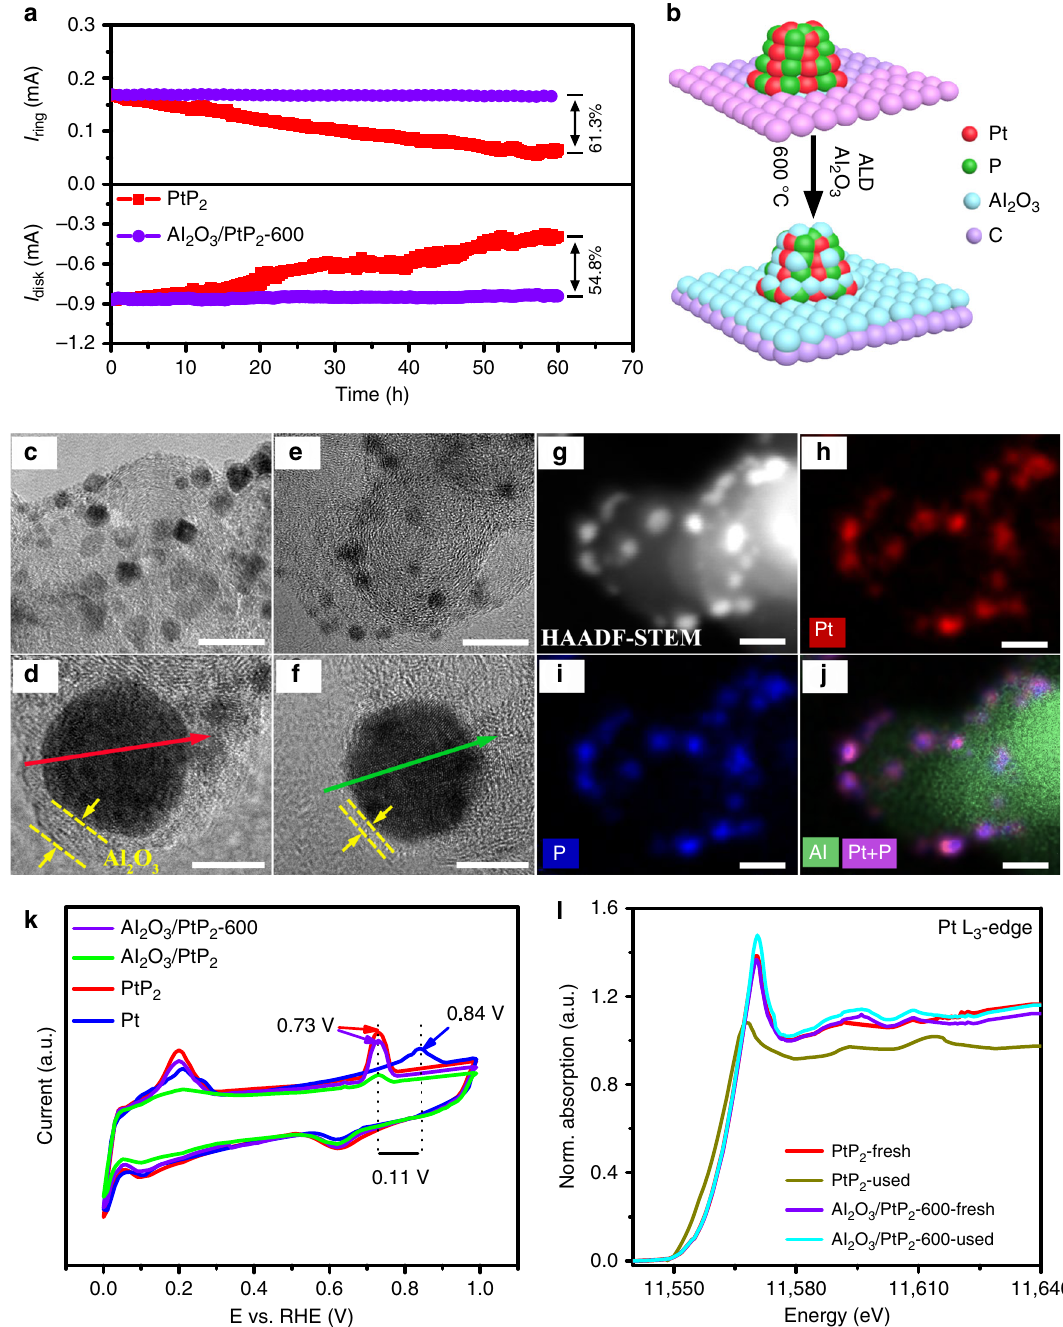
Fig. 4 Stabilization of NCs by ALD of Al 2 O 3 . a Disk and ring current stability of PtP 2 and Al 2 O 3 /PtP 2 -600 measured at a constant potential of 0.4 V vs. RHE for 60 h. b Depiction of Al 2 O 3 coating by ALD and subsequent activation. TEM images for c , d Al 2 O 3 /PtP 2 and e , f Al 2 O 3 /PtP 2 -600; scale bar, c , e 20 nm; d , f 3 nm. g – j HAADF-STEM image and corresponding elemental mapping for Al 2 O 3 /PtP 2 -600; scale bar, 10 nm. k Electrochemical